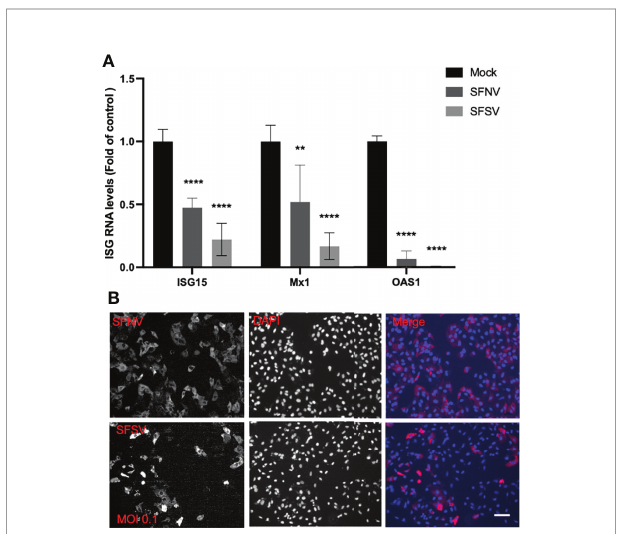
FIGURE 1 | Sand fl y virus infection inhibits type I IFN signaling. (A) HEK293T cells were infected with SFNV at an MOI of 1, and SFSV at an MOI of 0.1. The next day the cells were treated with IFN a (200 U/ml) for 12 h. The expression of ISGs (ISG15, Mx1, and OAS1) was quanti fi ed using qPCR. Shown are representative results from 2 independent experiments performed in triplicates (**P<0.01, ****P<0.0001, one-way ANOVA, Dunnett ’ s multiple comparisons test). (B) A549 cells were infected with SFNV or SFSV as described above. The next day, the cells were fi xed and stained with anti- SFNV or SFSV speci fi c antibodies. Bar=500